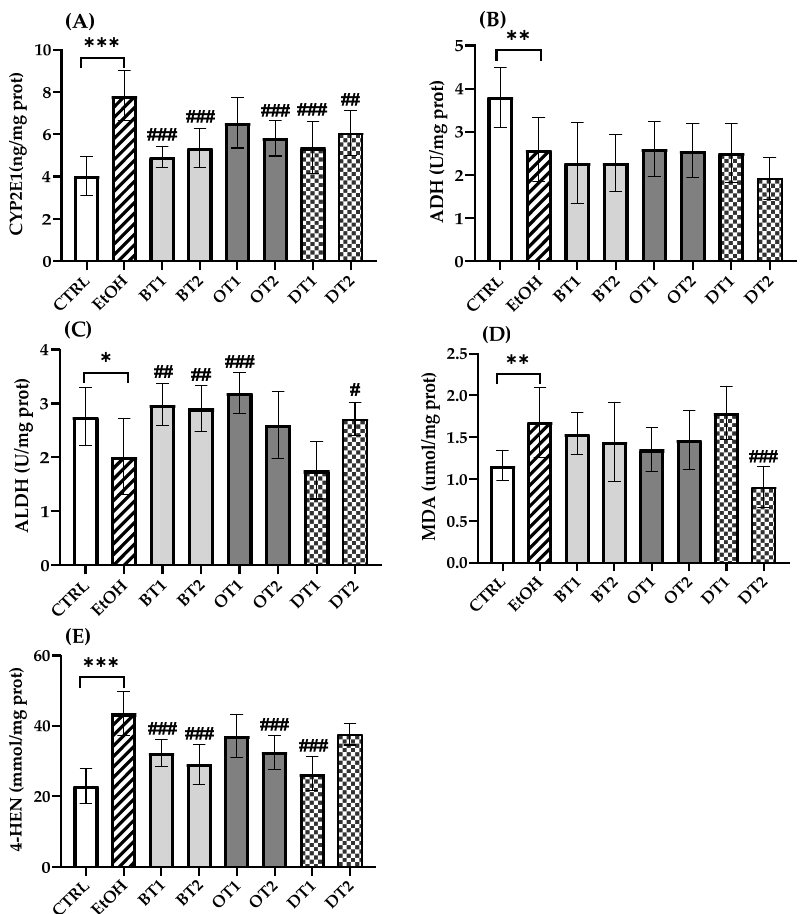
Figure 4. The effects of teas on alcohol metabolism and hepatic lipid peroxidation level in mice exposed to chronic alcohol consumption. ( A ) CYP2E1, cytochrome P450 2E1; ( B ) ADH, alcohol dehydrogenase; ( C ) ALDH, aldehyde dehydrogenase; ( D ) MDA, malondialdehyde; ( E ) 4-HNE, 4-hydroxynonenoic acid. CTRL, the control group; EtOH, the model group; BT1, Dianhong Tea; BT2, Yingde Black Tea; OT1, Tieguanyin Tea; OT2, Fenghuang Danzong Tea; DT1, Fu Brick Tea; DT2, Selenium-Enriched Dark Tea. * p < 0.05, ** p < 0.01, *** p < 0.001, the model group compared with the control group; # p < 0.05, ## p < 0.01, ### p < 0.001, the tea extract supplementary groups compared with the model